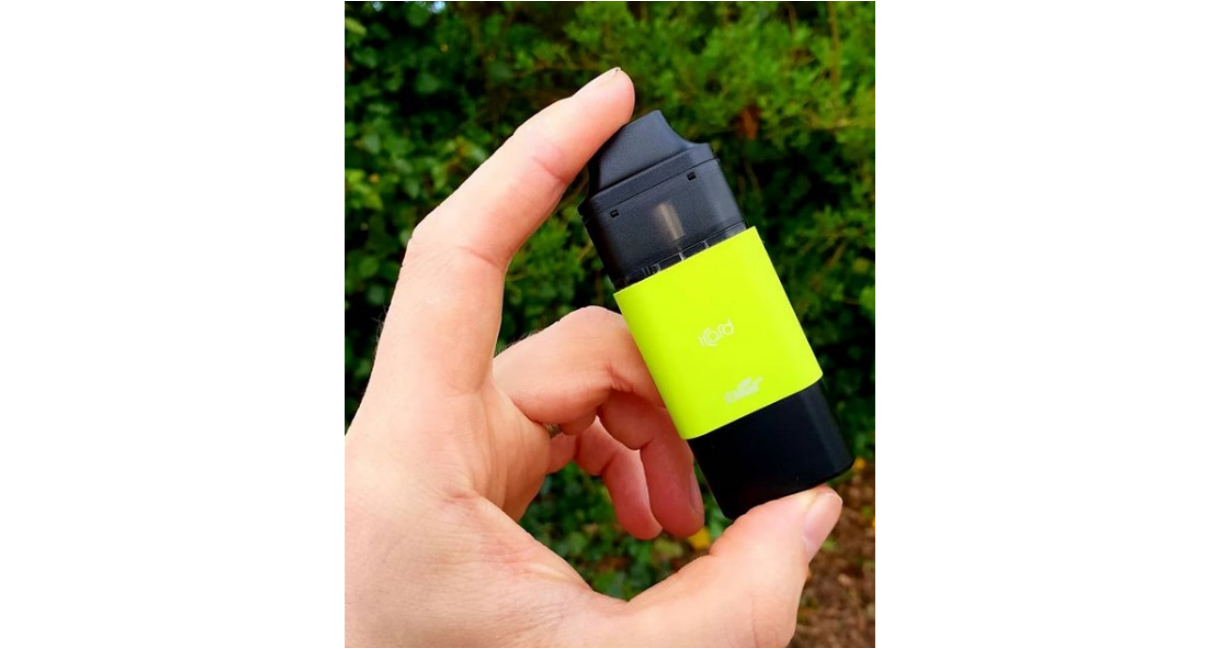
Figure 8. Example of a hand check post within the "behaviors and practices"